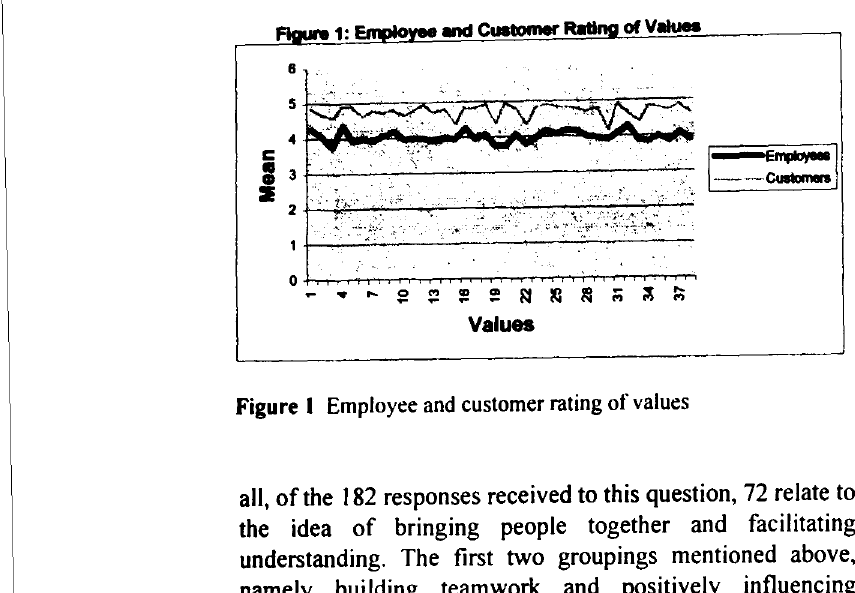
Figure I Employee and customer rating of values